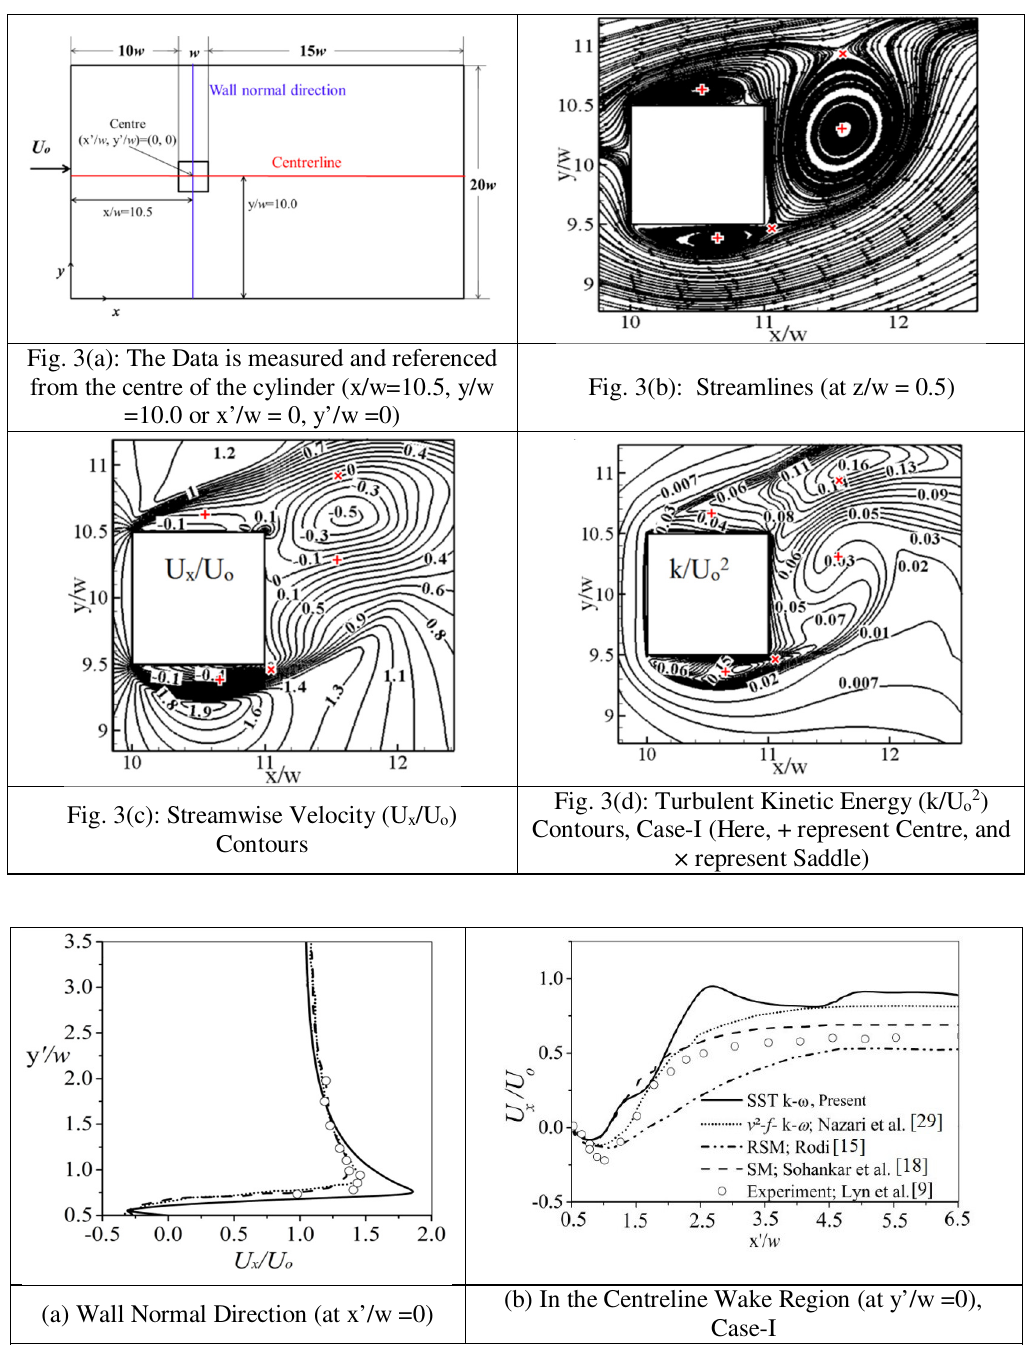
(b) In the Centreline Wake Region (at y’/w =0), (a) Wall Normal Direction (at x’/w =0) Case-I Fig. 4: Normalized Velocity (U x /U o )